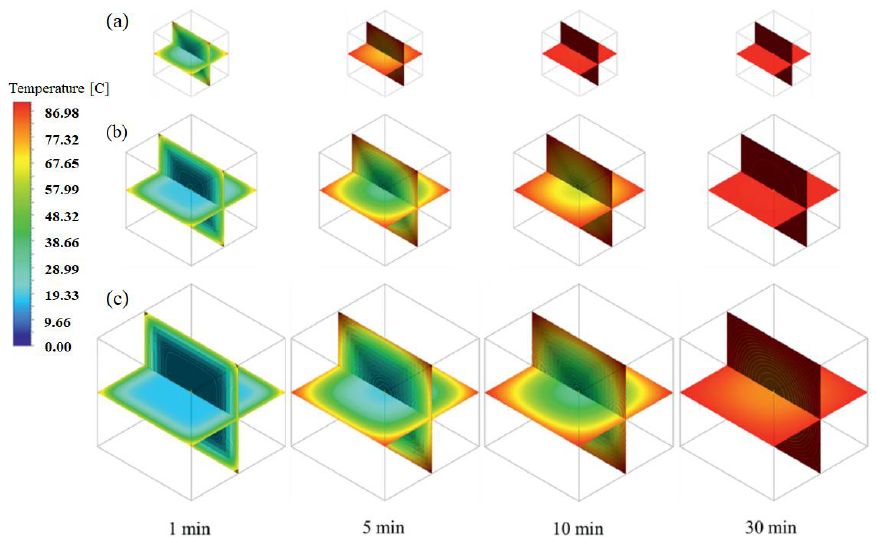
Figure 1. Estimation of the temperature profiles of surimi pastes (76% moisture) at 1, 5, 10 and 30 min for constant temperature (90 °C) water bath heating; ( a ) 2 × 2 × 2; ( b ) 3.5 × 3.5 × 3.5; and ( c ) 5 × 5 × 5 cm cubes, reproduced with permission from [62]; published by De Gruyter, 2016.